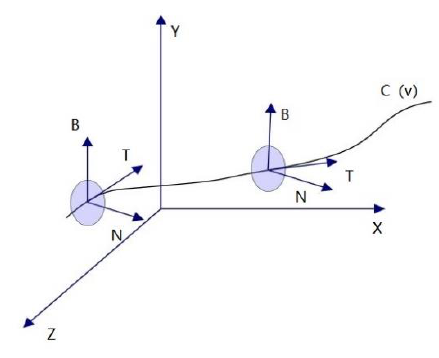
Figure 8. Moving frame diagram.